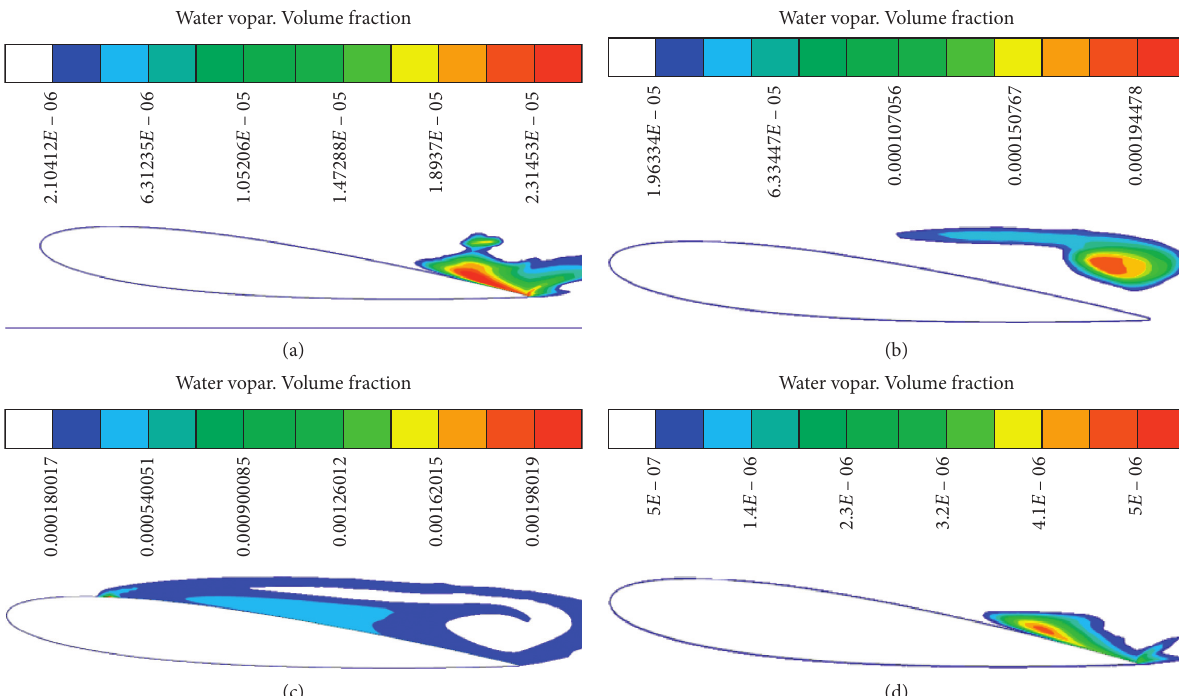
Figure 6: (a) 15 ∼ 2 cavitation nephogram. (b) 15 ∼ 4 cavitation nephogram. (c) 20 ∼ 2 cavitation nephogram. (d) 20 ∼ 4 cavitation